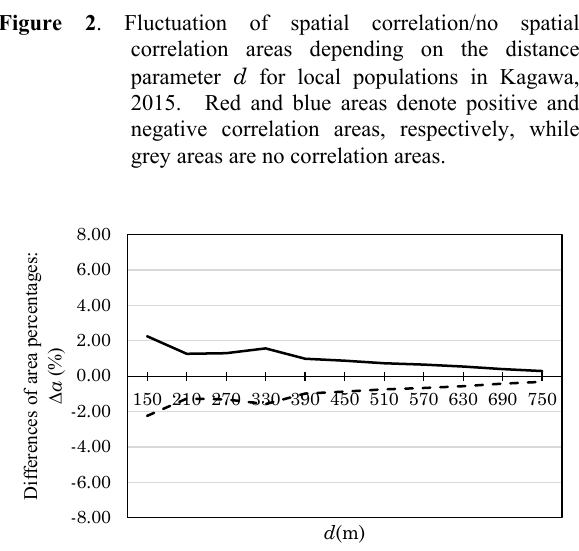
Figure 3 . Fluctuation of the differences of spatial correlation/no spatial correlation areas between contiguous distances for local population in Kagawa, 2015. A solid line means  a of positive spatial autocorrelation areas, while a dotted line is that of negative and no spatial autocorrelation